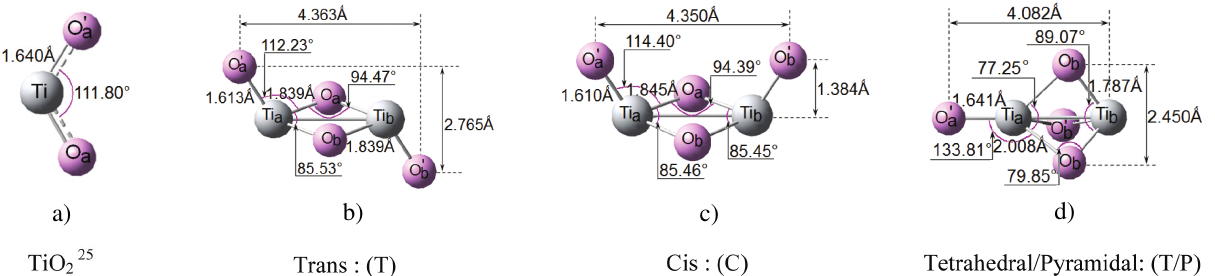
Figure 1 . Labeling and selecting geometrical parameters for the studied dimers. TiO